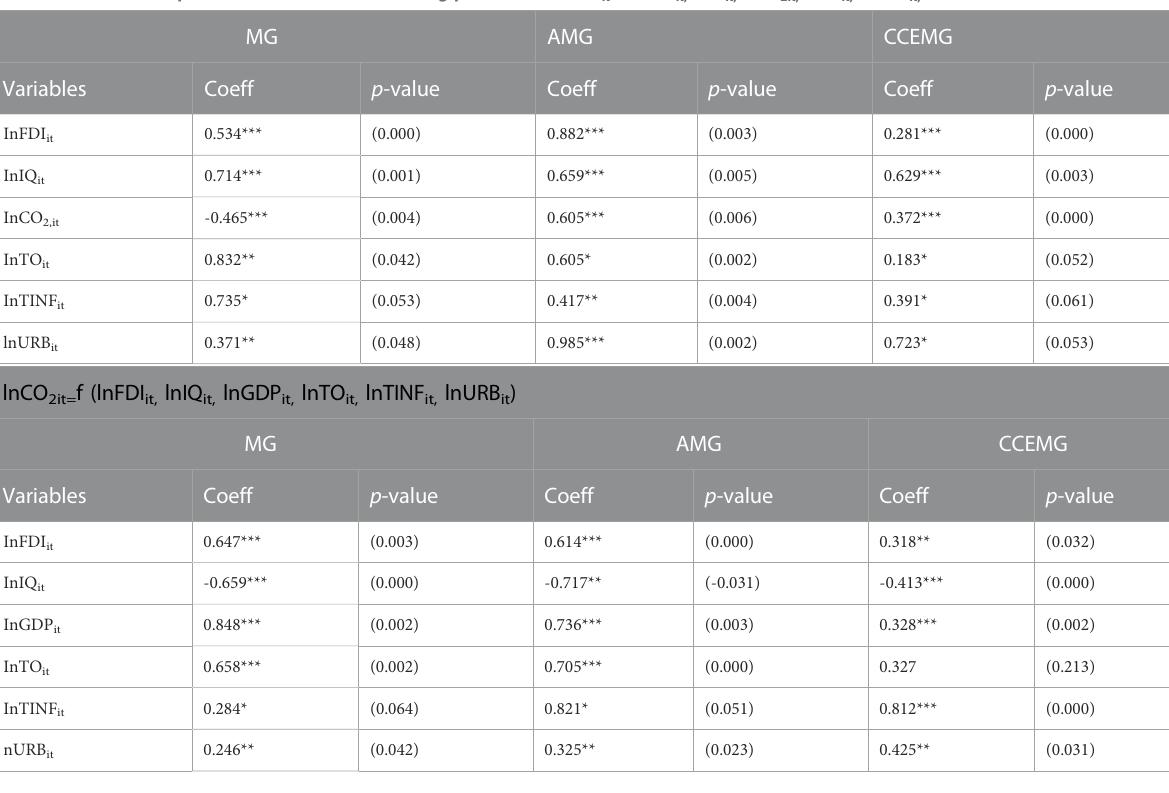
TABLE 6 Results of the panel AMG method for estimating parameters, lnGDP it= f (lnFDI it, lnIQ it, lnCO 2it, lnTO it, lnTINF it, lnURBit).